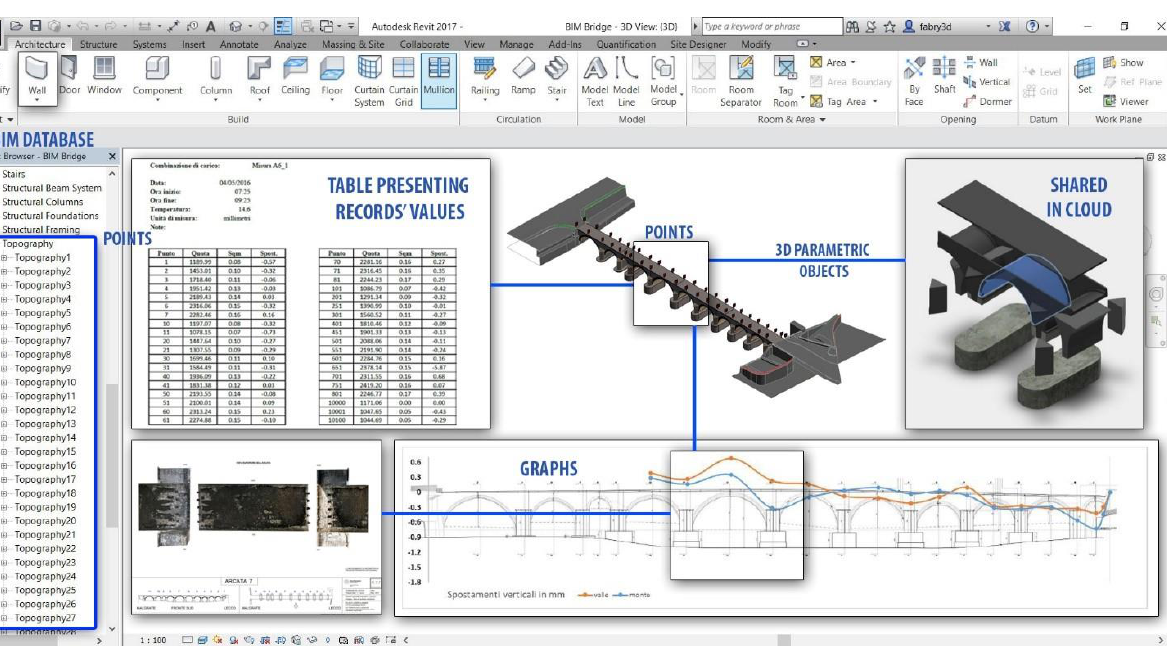
Fig. 1. The Historic BIM of Ponte Azzone Visconti in Lecco. The connection between model, leveling benchmarks and results after least squares adjustment of leveling